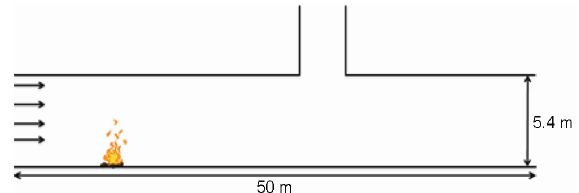
Fig. 5. Model configuration of the tunnel